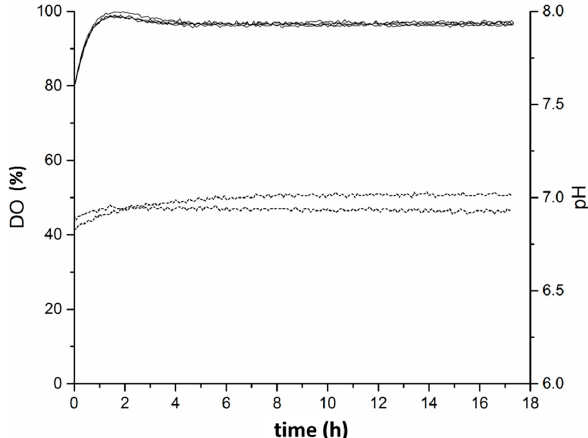
Figure B1. Dissolved oxygen (DO) and pH measurement of one flow chamber system experiment with glass coupons. Straight lines: DO results of two chambers, each with two measuring points; dashed lines: pH measurement in two flow chambers, each with one measurement point.